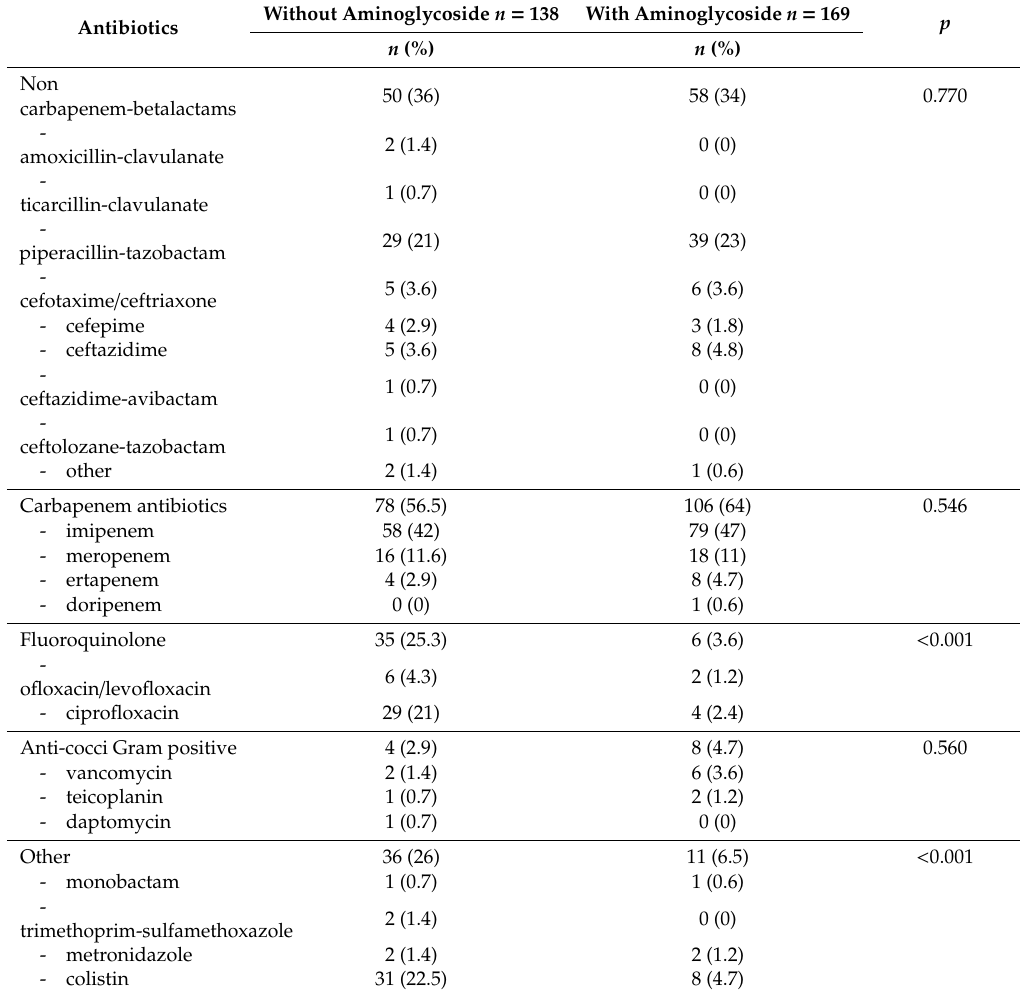
Table 2. Comparison of antibiotics used in the empirical regimen among patients treated with or without